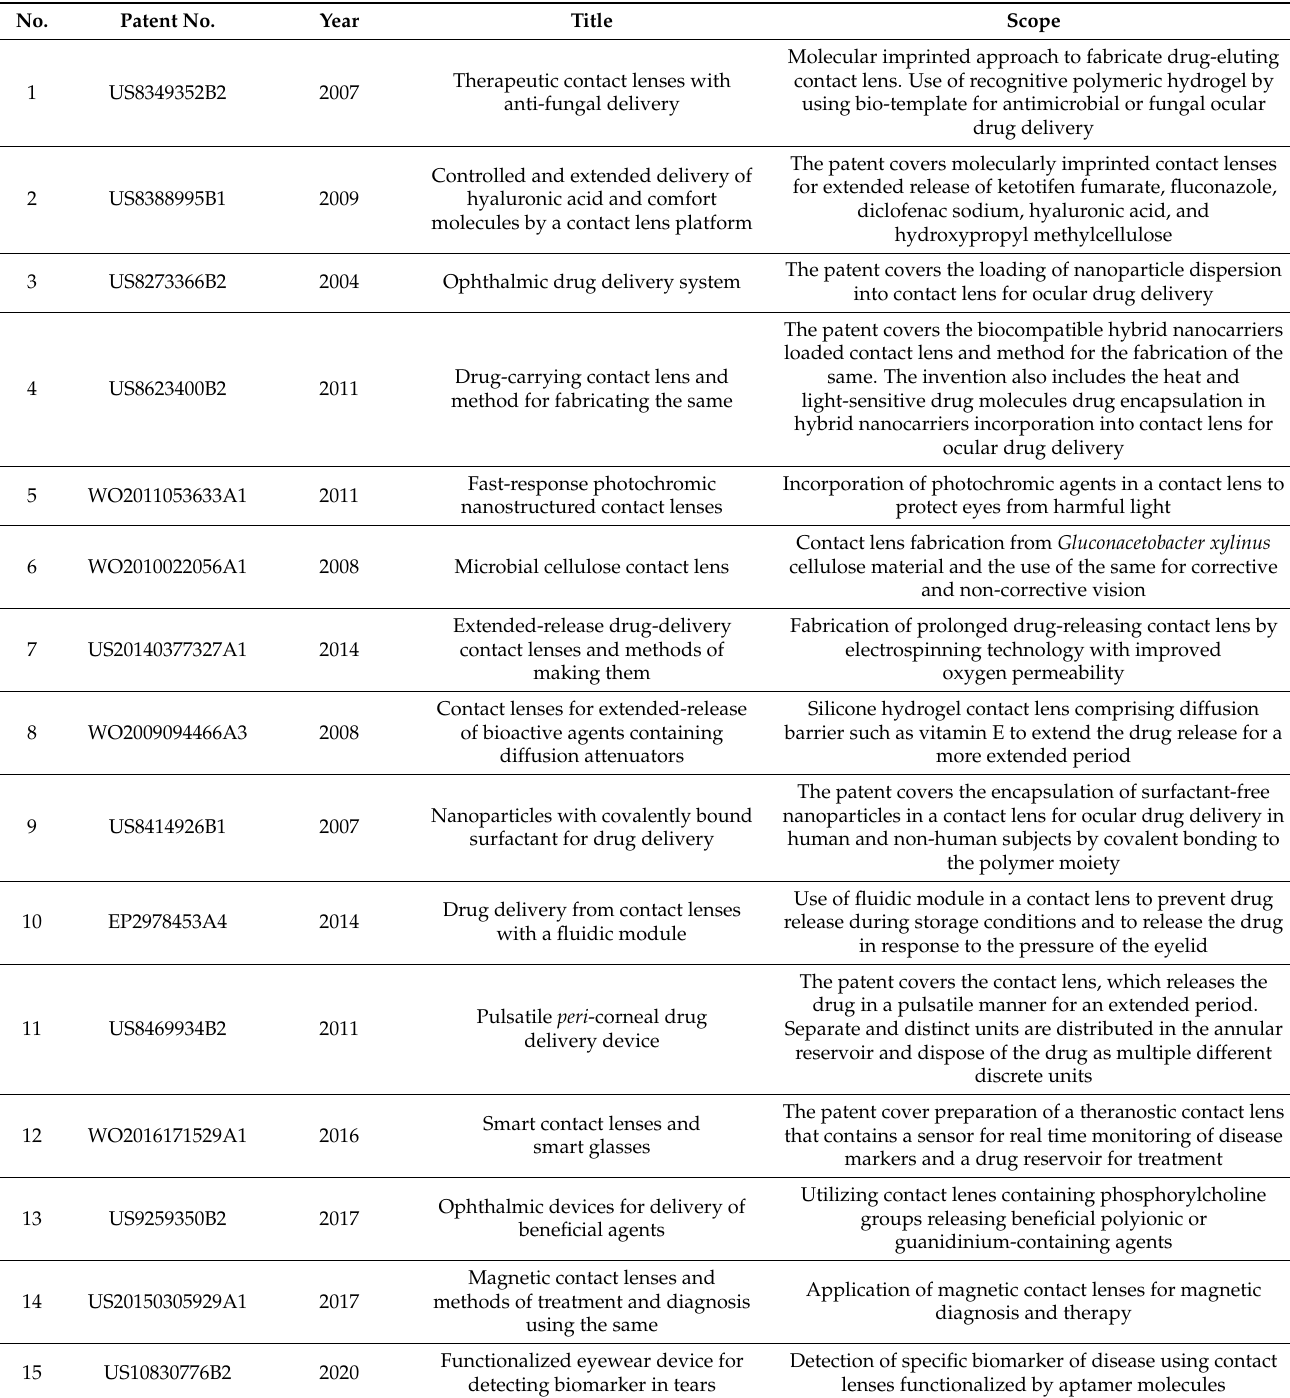
Table 2. Patents related to the therapeutic application of contact lens. Reprinted with permission from Ref. [158]. 2023,